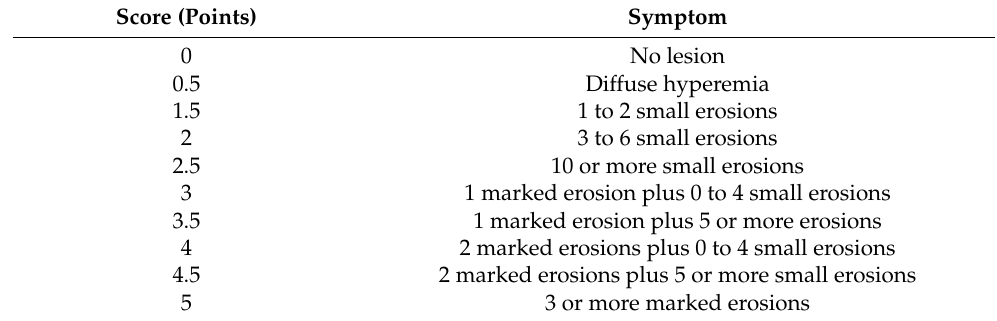
Table 1. Macroscopic damage